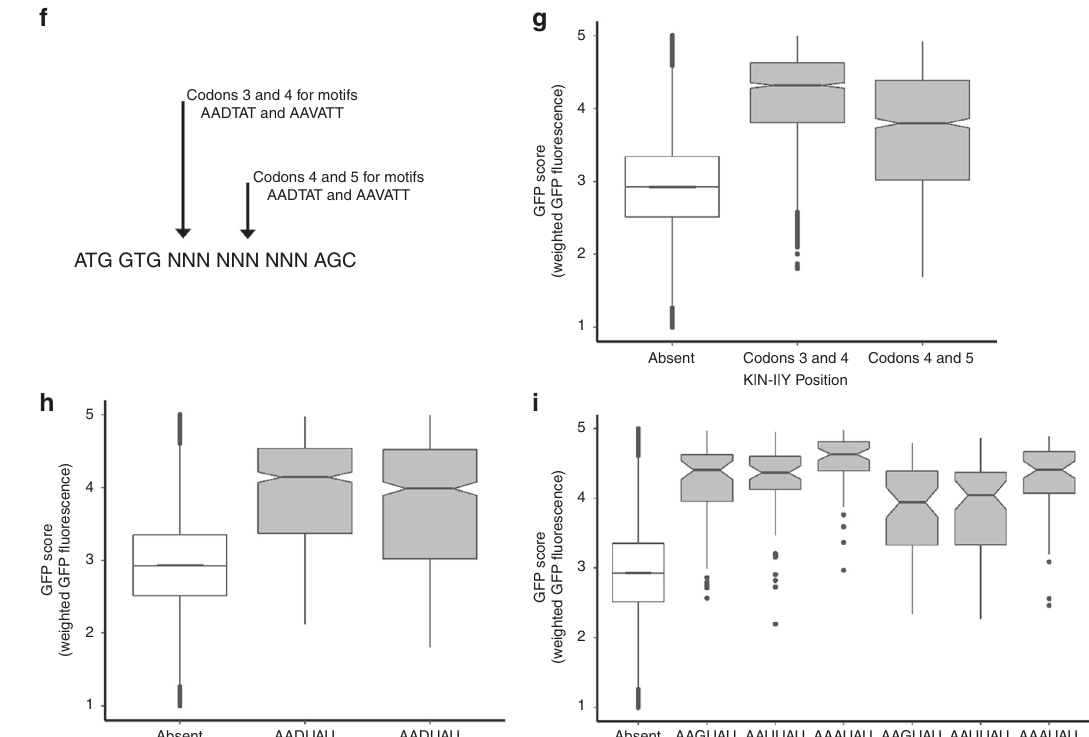
different levels that correlated with the GFP score determined from our library (Fig. 5b and Supplementary Fig. 18). Noticeably in vivo expression of eGFP variants from both polycistronic vectors, as well as in vitro expression from T7 polymerase transcribed polycistronic mRNAs, recapitulated data using